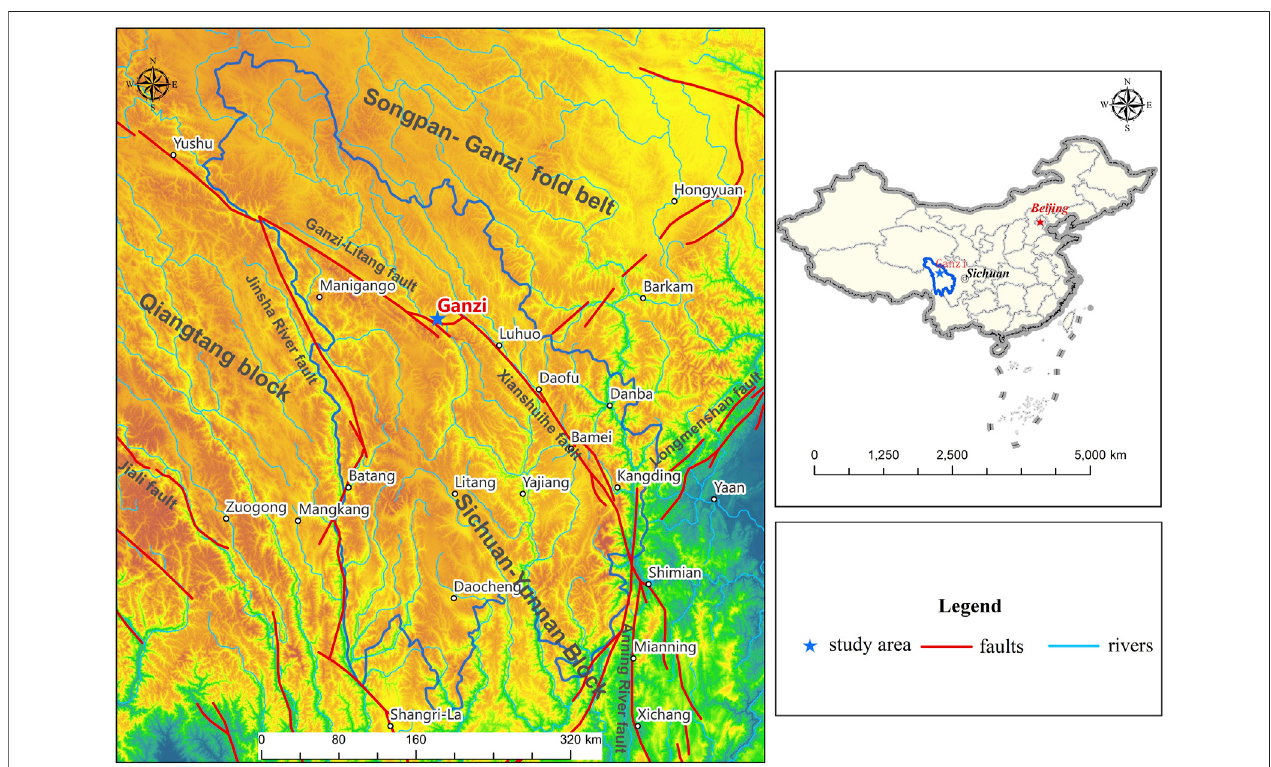
FIGURE 1 | Geographical location of the study